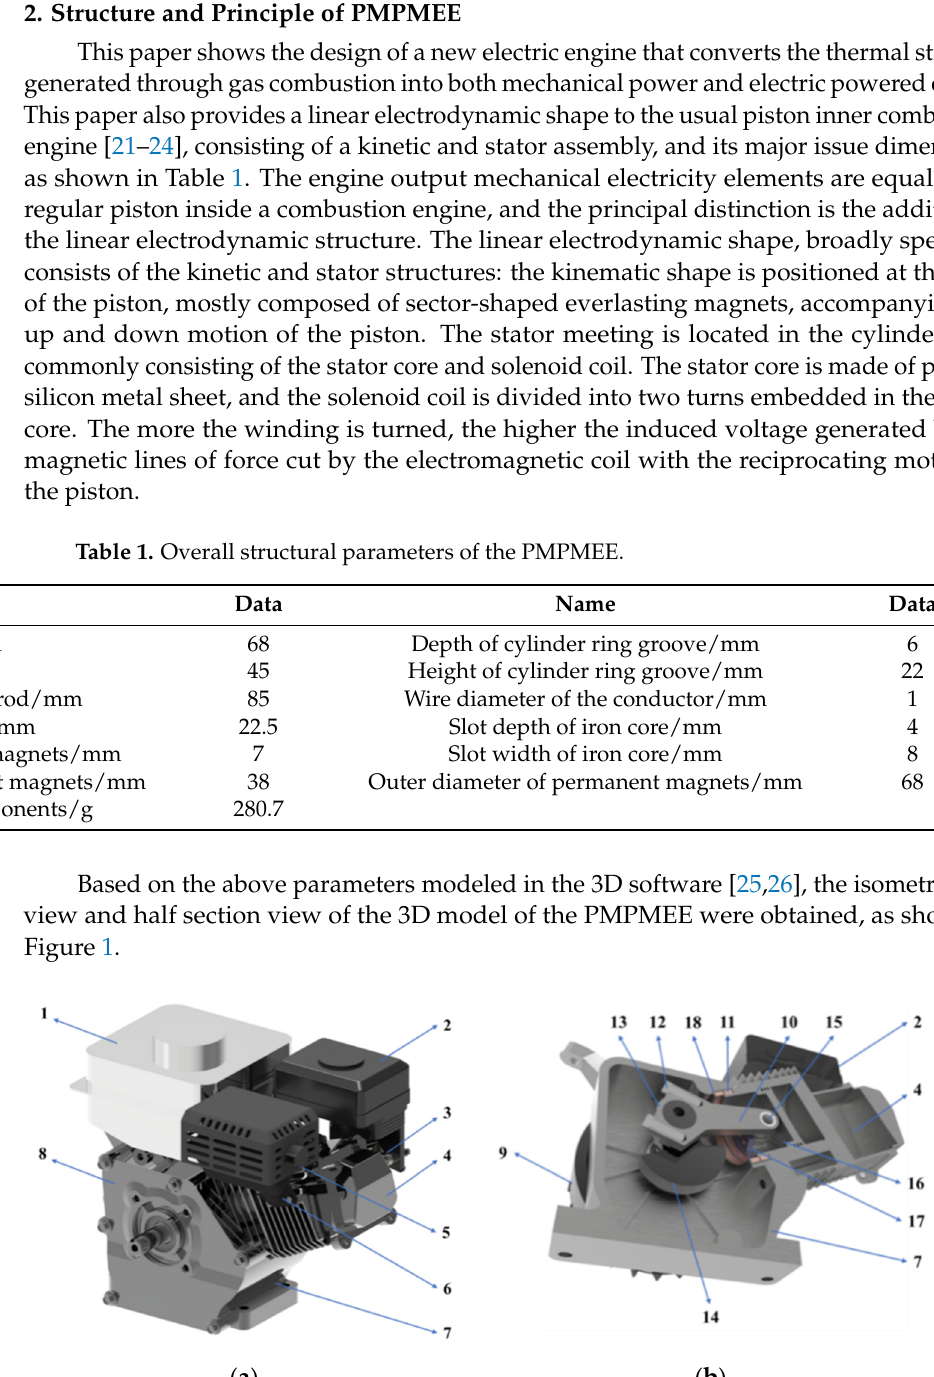
magnet; 18—Silicon steel sheet iron